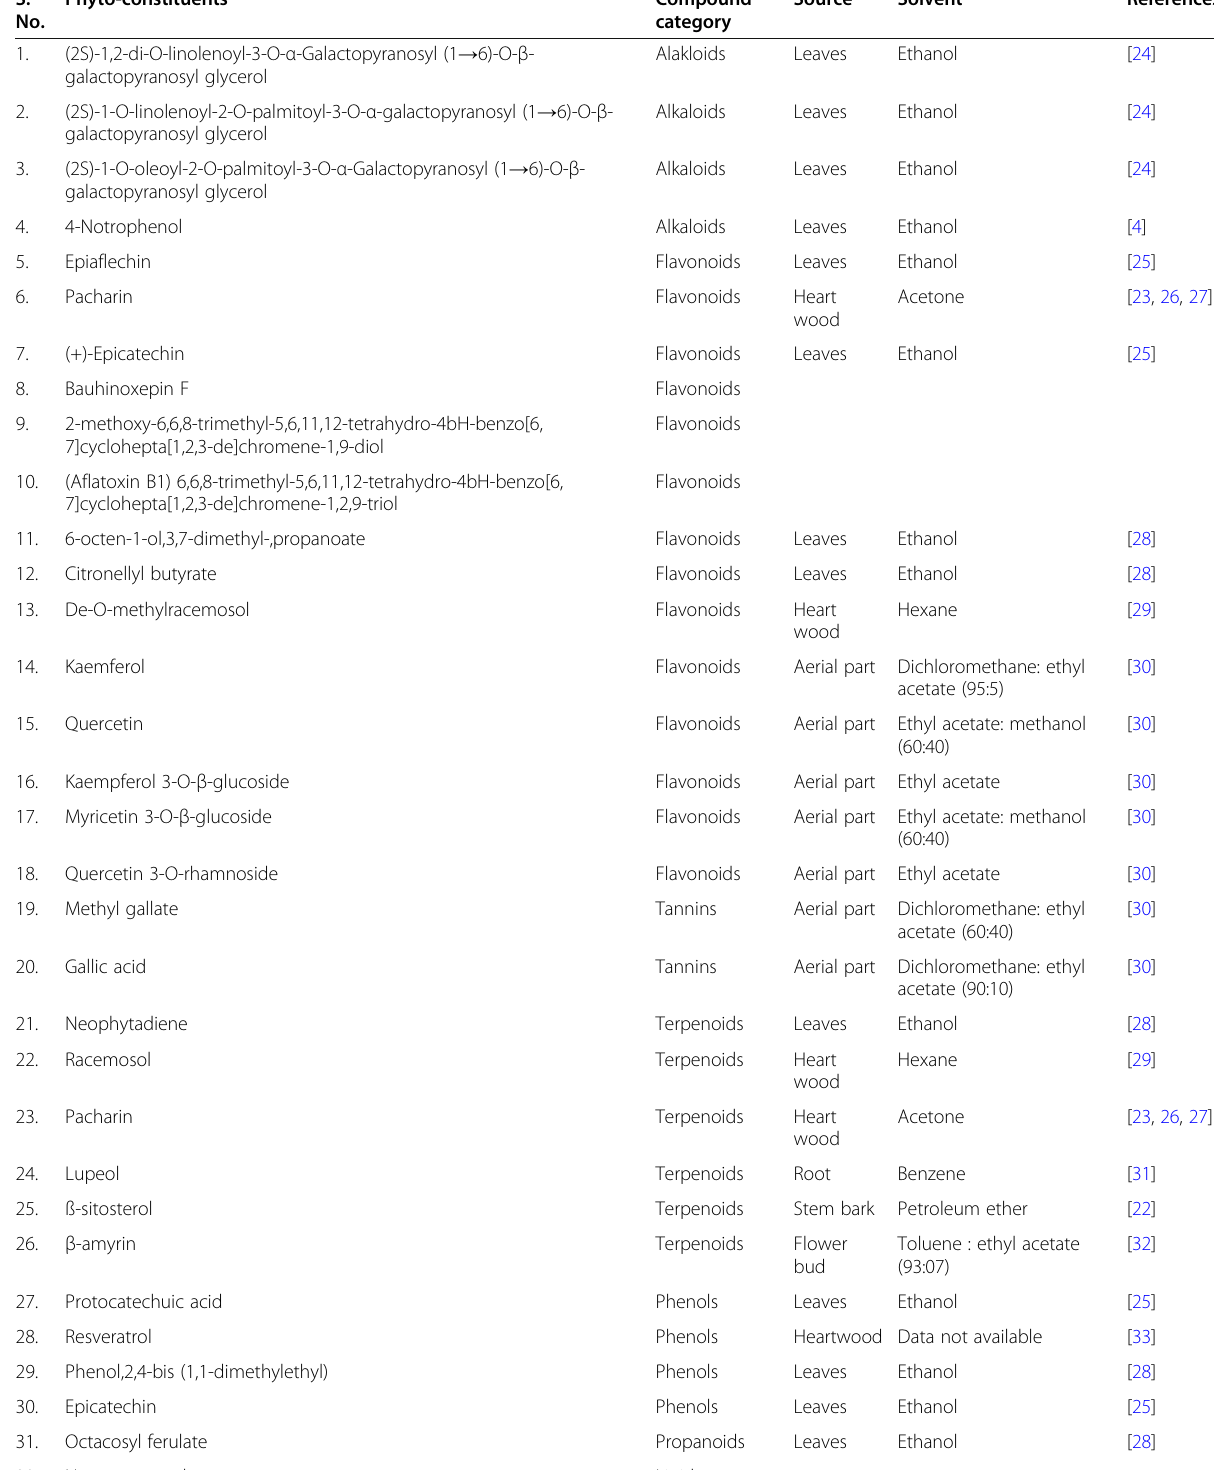
Table 2 Phytoconstituents of B . racemosa that have been extracted by different